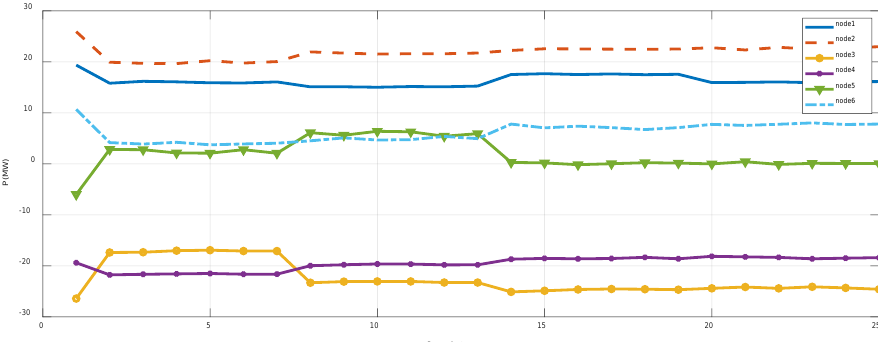
Figure 7. Active powers in normal operating states.